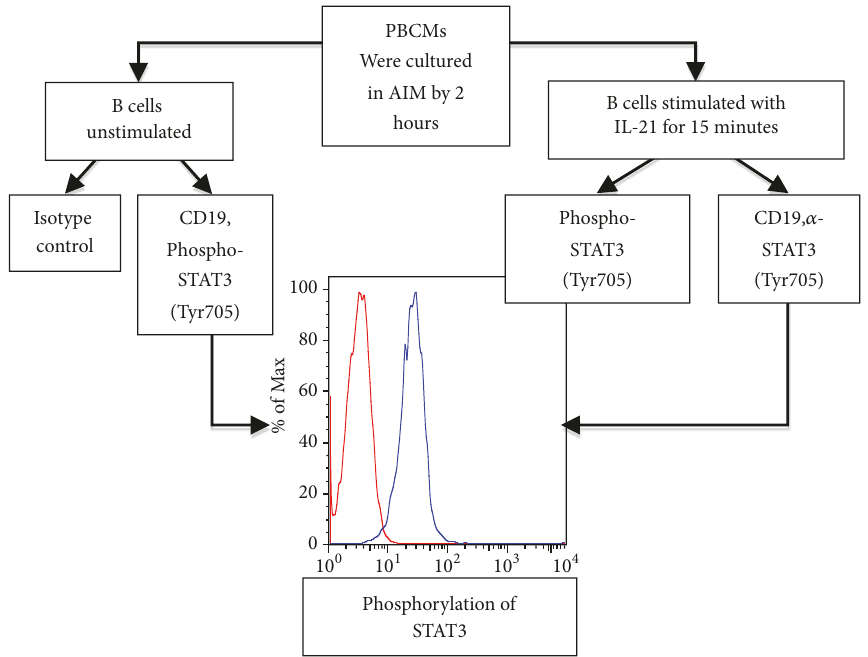
Figure 4: Evaluation of STAT3 phosphorylation by flow cytometry.